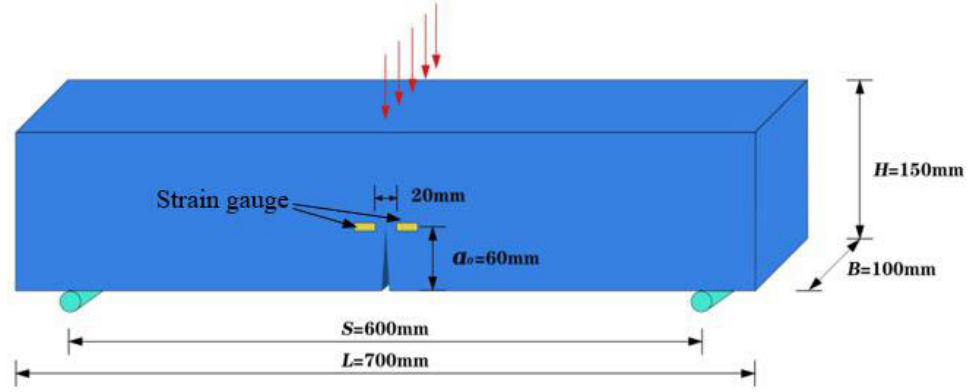
Figure 2: Sketch of three-point bending